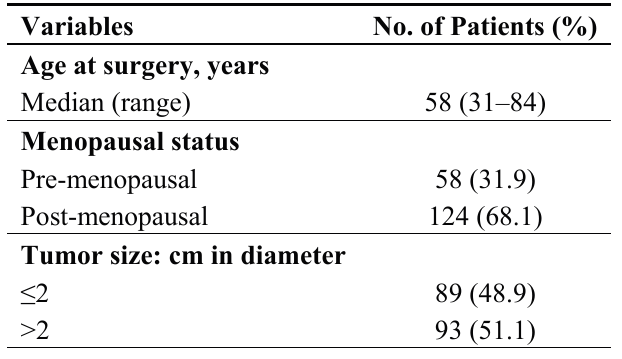
Table 1. Main characteristics of study patients (N =